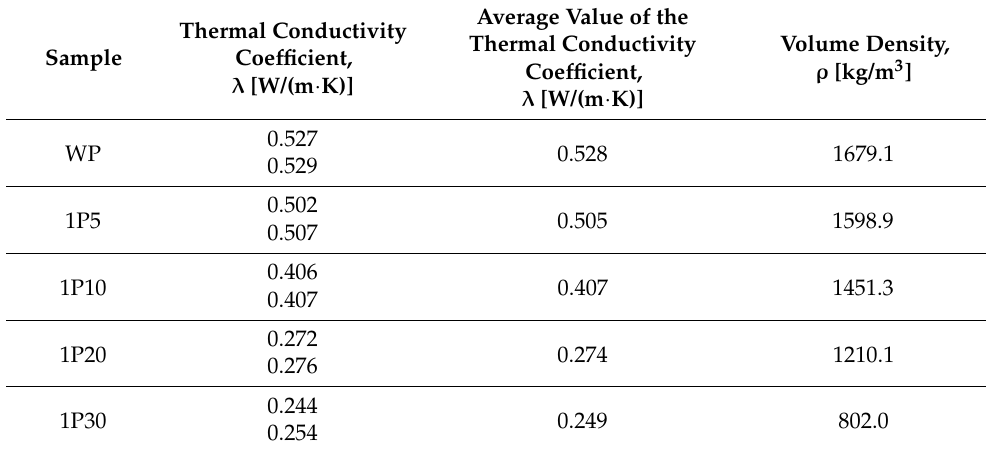
Table 3. Test results for the thermal conductivity coefficient and volume density of GFG modified lime-sand products with a diameter of 0.25–0.5